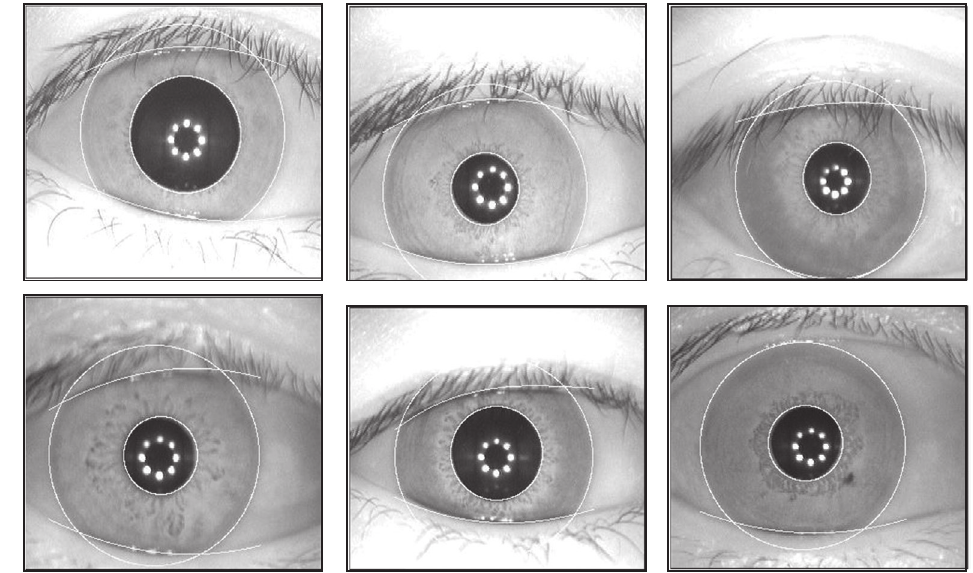
Figure 12. Samples of the Best Segmented Iris Region with the Proposed